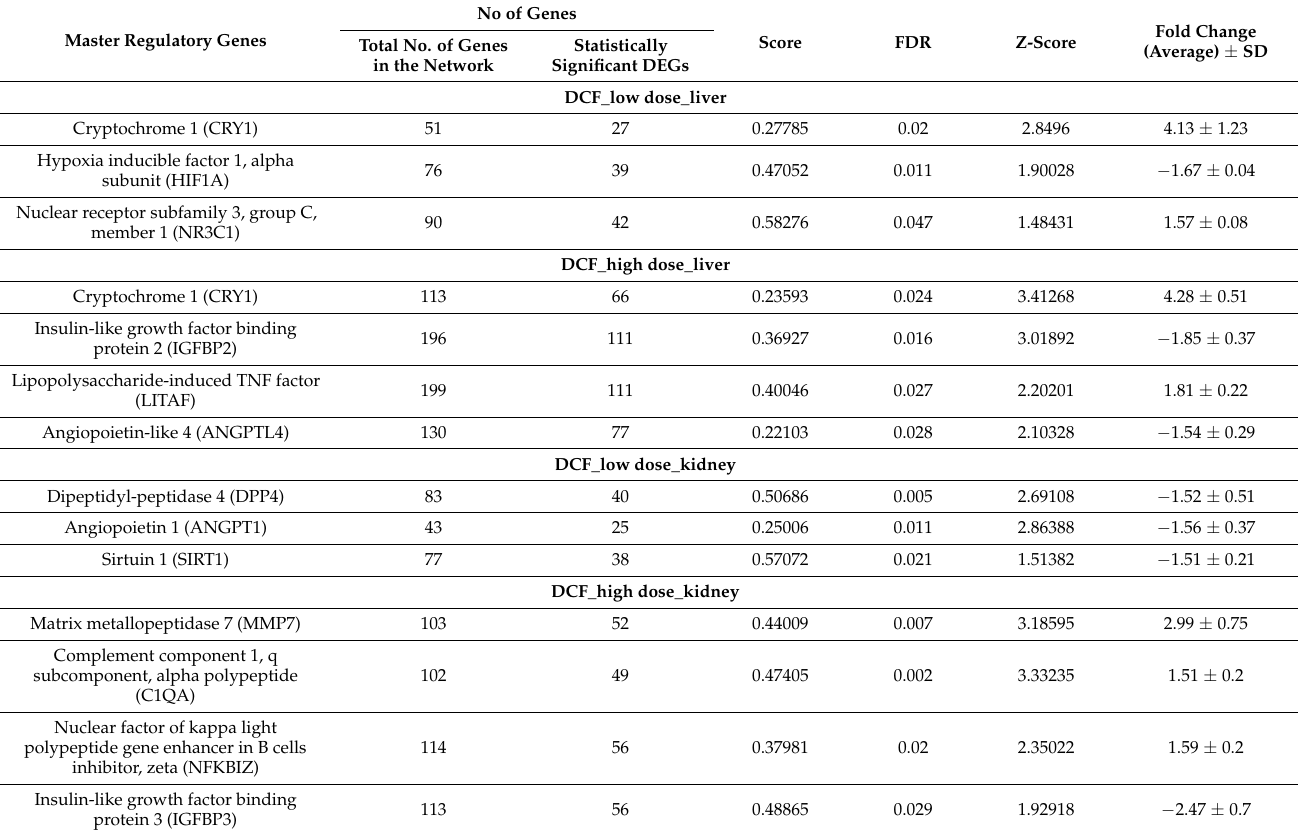
Table 8. Master regulatory genes in the liver and kidney after low- and high-dose diclofenac treat- ments. The key master molecules were identified and their regulatory networks were constructed using the GeneXplain software. Given is a summary of master regulatory genes and the associated networks with the number of total interacting genes and DEGs, network score, Z-score and average fold change. The filtering criteria Z- Score > 1 and Score > 0.2 were set to select statistically significant master